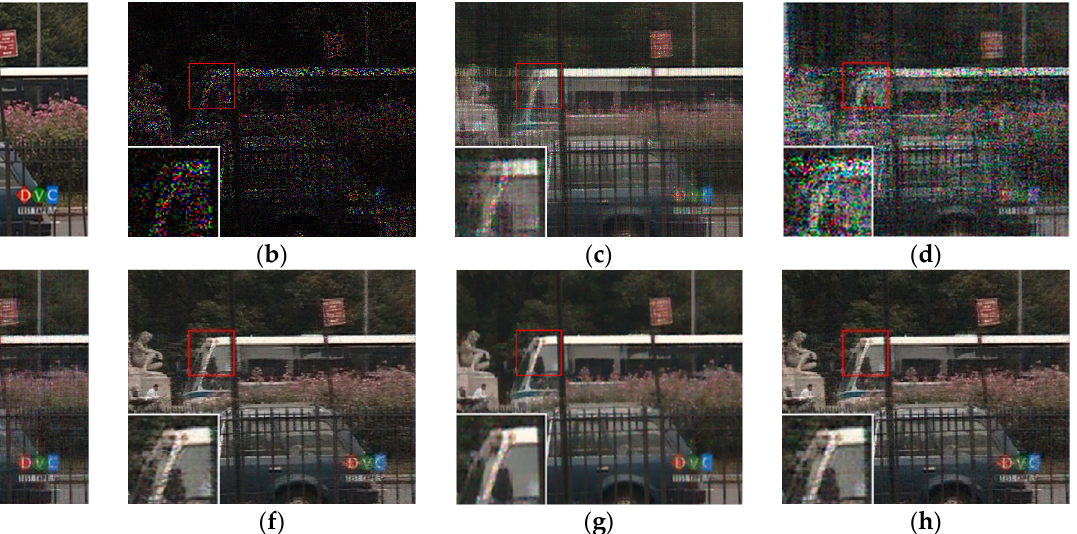
Figure 15. Visual effect comparison of different methods on the ninth frame completion of the Bus